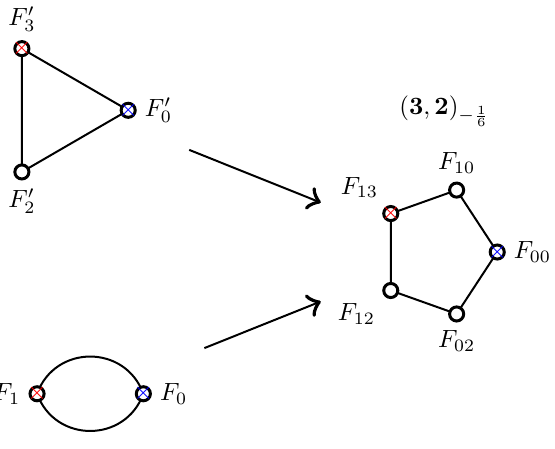
Kodaira fibers over the codimension- 3 (over d = 0 e 1 − 1 / 6 (respectively, ˆ D ) intersects 0 1